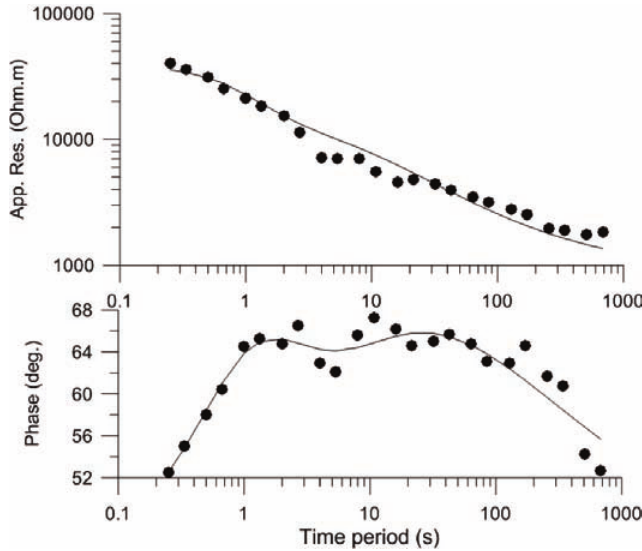
Figure 7. Fits for the apparent resisitivity data (top) and the phase data (bottom) for the observed (solid circles) and model (lines) responses for the transverse electric mode data.